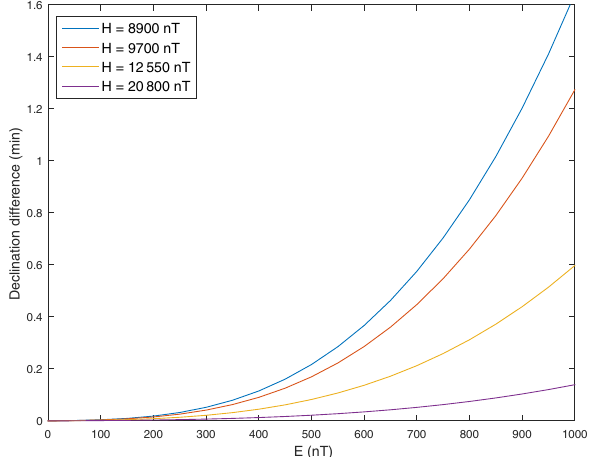
Figure 1. A comparison of the difference between the computation of declination from E using the small angle approximation and the exact formula. The difference is shown for three high-latitude ob- servatories and one mid-latitude